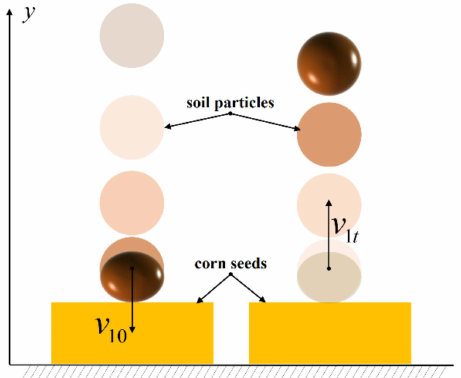
Figure 4. Process analysis of soil particle colliding with